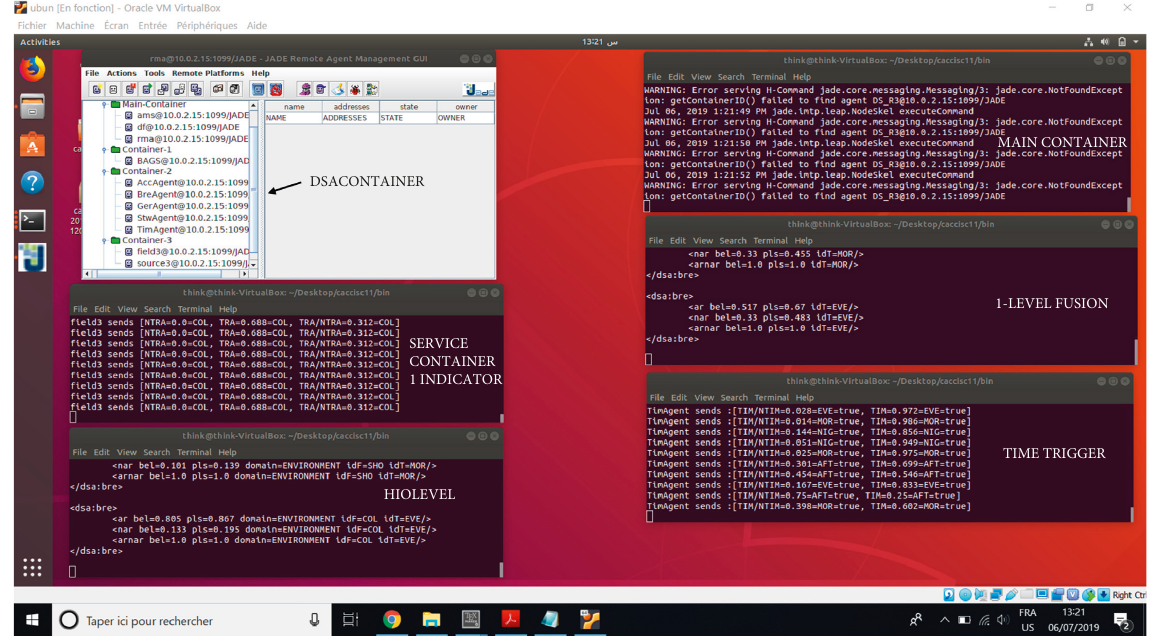
Figure 3: Small-scale simulation of case study as expanded in